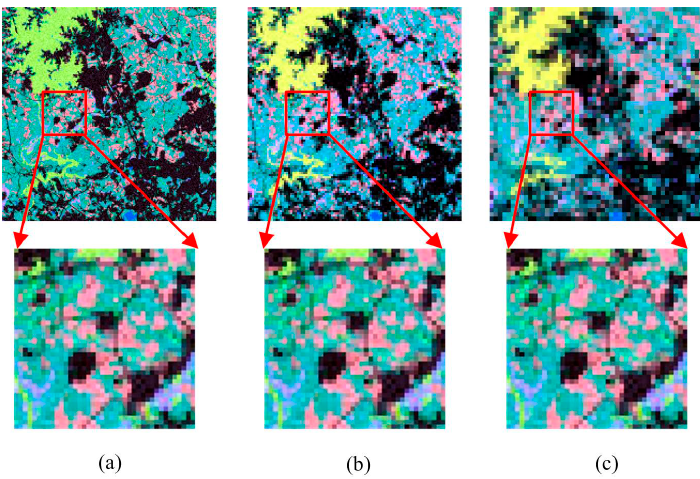
Figure 5. Simulated coarse spatial resolution images for FCM_STSRM in experiment 1: ( a ) z = 4; ( b ) z = 8; and ( c ) z = 16.